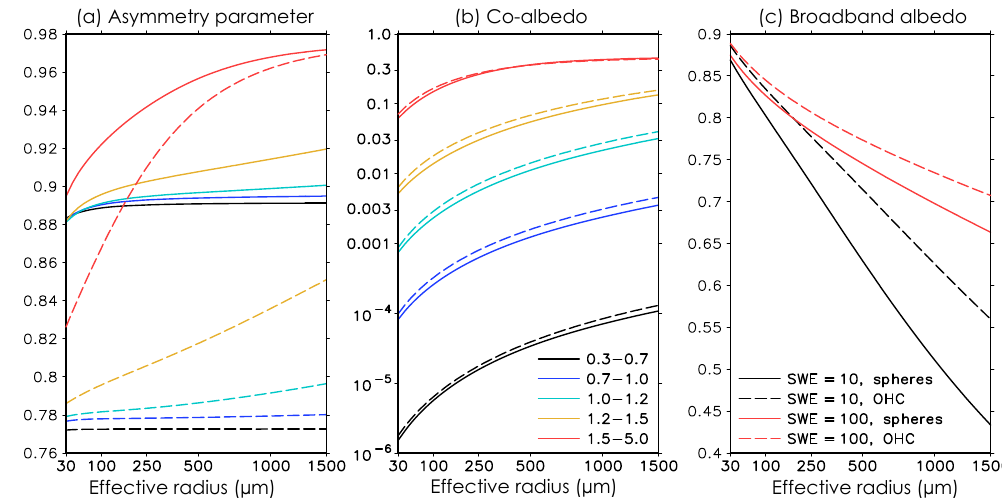
Figure 1. (a) Asymmetry parameter and (b) single-scattering co-albedo of snow grains for the five spectral intervals of SNICAR for spheres (solid lines) and for the OHC (dashed lines) as a function of snow grain effective radius. See the legend in panel (b) for the intervals (in µm). (c) Corresponding broadband (0.2–5.0µm) albedo of pure snow for snow water equivalents of SWE = 10kgm − 2 (black lines) and SWE = 100kgm − 2 (red lines). Snow albedo was computed using the delta-Eddington method in the visible region and the delta-hemispheric mean method in the near-IR region assuming an underlying surface albedo of 0 and direct incident solar radiation with a zenith angle of 60 ◦ and with a spectral distribution corresponding to a cloud-free midlatitude winter atmosphere.